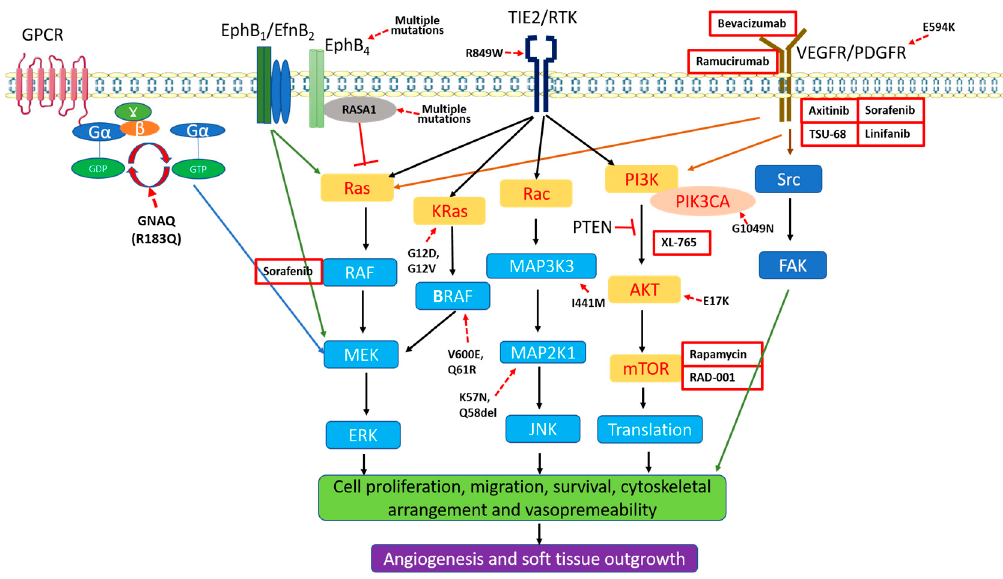
Figure 2. The potential roles of aberrant activations of MAPK and PI3K signaling pathways in pathogenesis of PWS / SWS. Mutations in GNAQ , EphB4 , RASA1 , Tie2 and other genes, as well as co-expression of EphB1 / EfnB2 lead to an activation of MAPK. Mutation in PIK3CA (G1049N) activates AKT / mTOR pathway. Overexpression of VEGF-A and VEGFR2 can activate in MAPK and AKT / mTOR. Altogether, these factors lead to aberrant activations of MAPK and PI3K signaling pathways, thus result in cell proliferation, migration, survival, cytoskeletal arrangement and vasopermeability, eventually causing development of PWS / SWS. Some anti-angiogenesis compounds or antibodies that are under development or have been approved by FDA are listed in the figure for potential treatments of vascular malformations.